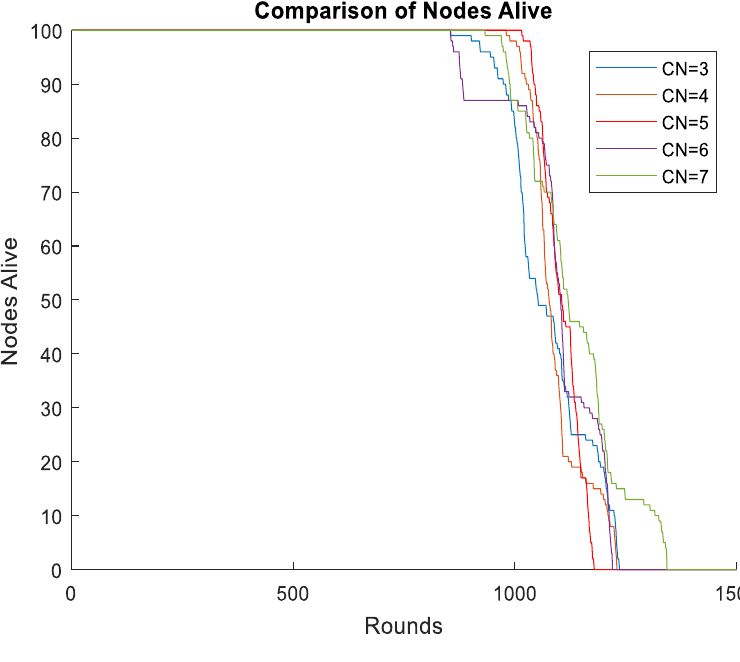
Figure 13. Different number of clusters.